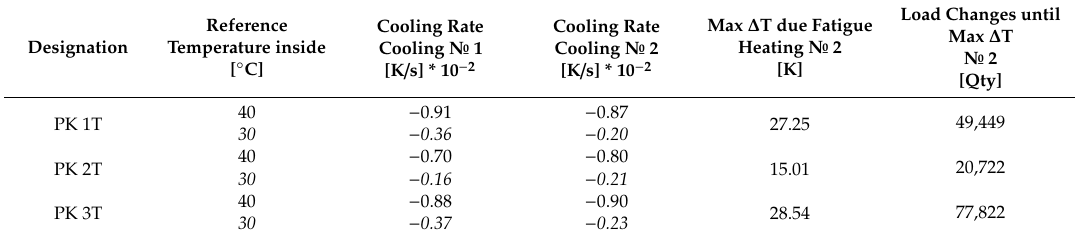
Table 3. Cooling rates at temperatures of 30 ◦ C and 40 ◦ C in the centre of the sample during first (after oven heating) and second cooling (after fatigue heating) as well as the number of load cycles and resulting temperature di ff erences due to the fatigue